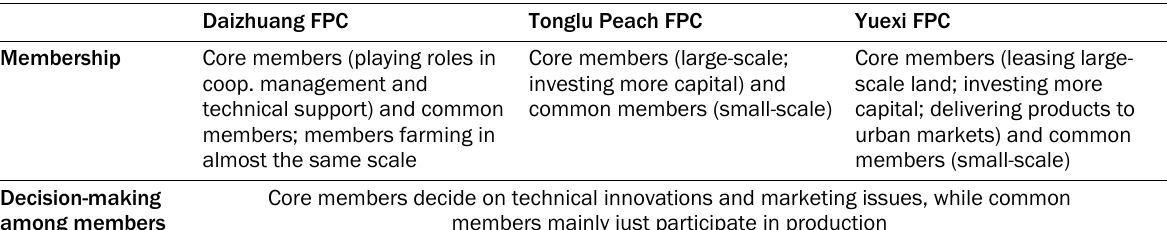
Table 4. Membership and Decision-making in Three